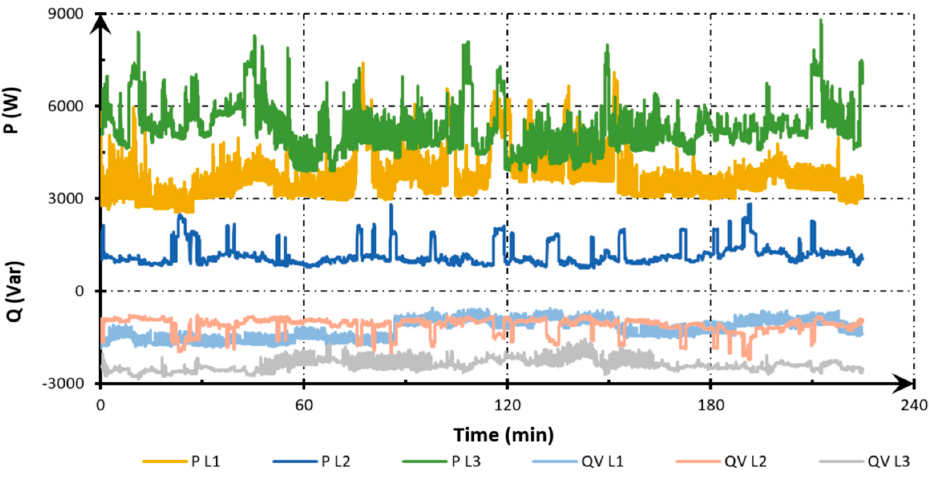
Figure 3. The course of power variation in the monitored period on individual phases L1, L2, L3.